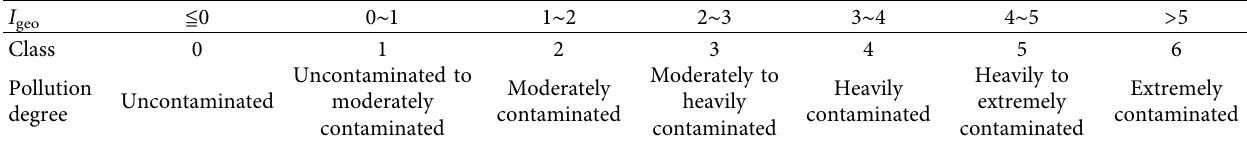
Table 1: I geo and classification of sediment pollution degree.